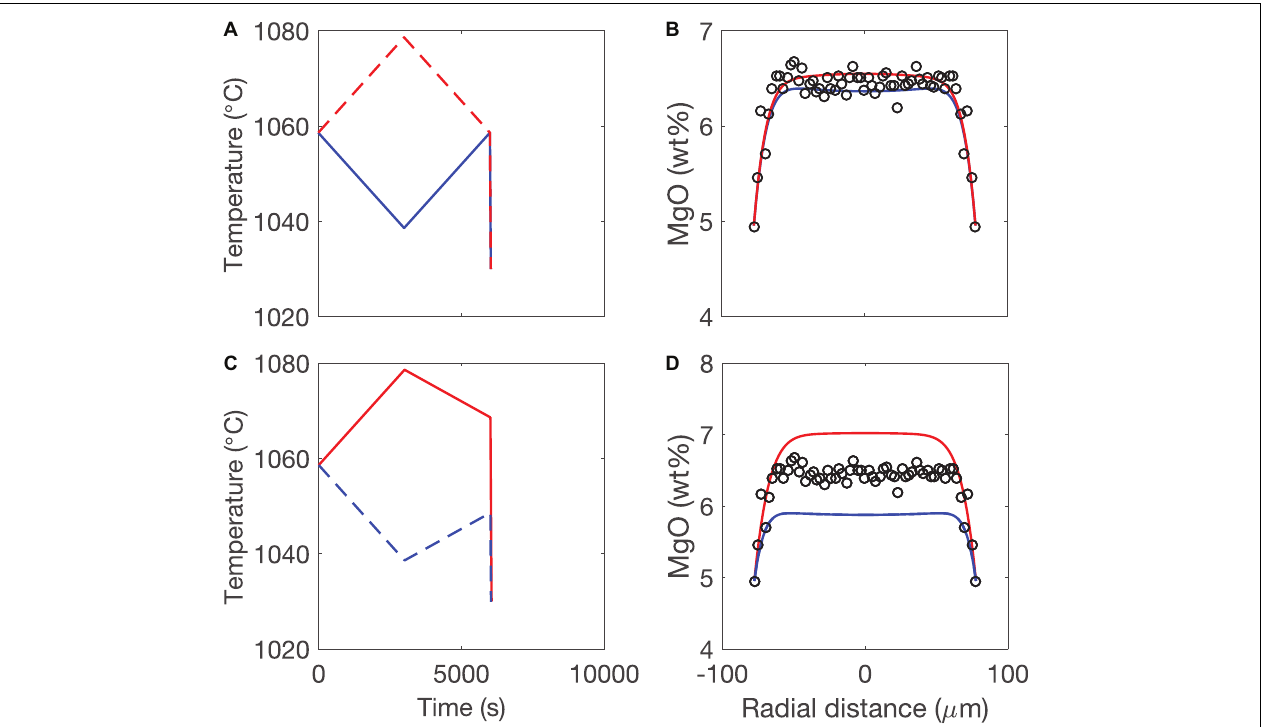
FIGURE 10 | Forward modeling to calculate the effects of temperature variations of ± 20 ◦ C on the generation of MgO zonation in inclusion Seg5-MI1. (A) Two separate thermal histories are imposed: one in which the temperature increases and decreases by 20 ◦ C over a period of 100 min before quenching at 0.9 ◦ C/s (red dashed lines); and one in which the temperature first decreases and then increases by 20 ◦ C over a period of 100 min before quenching at 0.9 ◦ C/s (blue lines). (B) Modeled MgO zonation in melt inclusion Seg5-MI1 in response to the thermal histories imposed in (A) . Both models (red and blue curves) provide a reasonably good match to the data (black circles). In these examples, the imposed temperature variations occur over a long enough duration that MgO variations are able to approximately homogenize by diffusion, thereby erasing the evidence of the prior thermal histories. (C) Imposed thermal histories used to generate the model curves in (D) . Note that in these examples, there is a net temperature change of ± 10 ◦ C between the initial temperature and the temperature reached just prior to quenching. (D) Modeled MgO zonation in melt inclusion Seg5-MI1 in response to the thermal histories imposed in (C) . Thermal histories in which we impose a net 10 ◦ C increase (red curve) or net 10 ◦ C decrease (blue curve) in temperature prior to quenching are unable to match our Seg5-MI1 data. This demonstrates the sensitivity of MgO zonation in Seguam melt inclusions to net temperature changes during magma ascent.